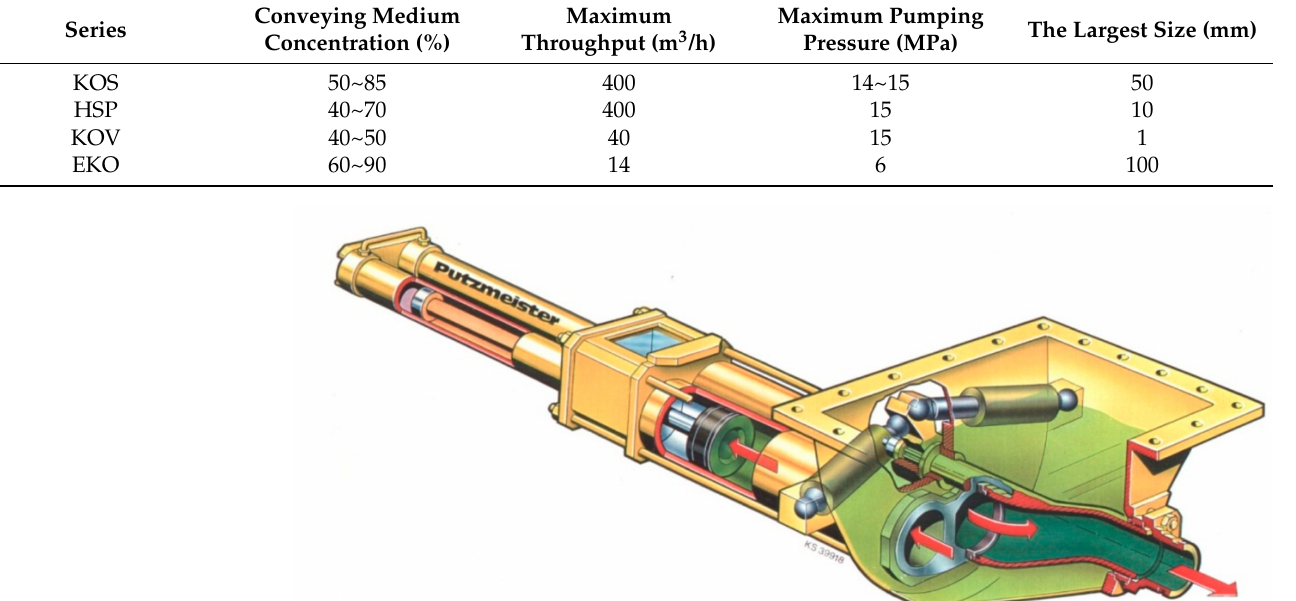
Table 1. Comparison of characteristics of Putzmeister series filling industrial pumps.